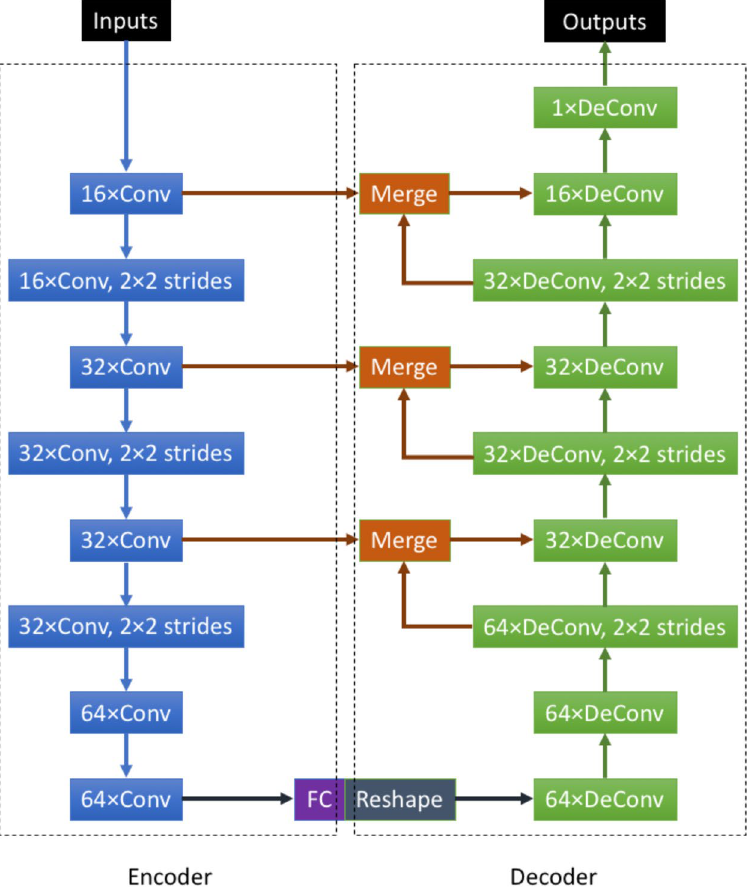
Figure 9. Image transformation model of CNN. “Conv” is the abbreviation of convolution kernel. “DeConv” is the abbreviation of deconvolution kernel. The numbers before the “Conv” or “DeConv” are the numbers of kernels. “FC” is the abbreviation of fully connected layer. All the convolutional and deconvolutional layers use 3 × 3 kernels. All the layers use Relu as the activation functions 43